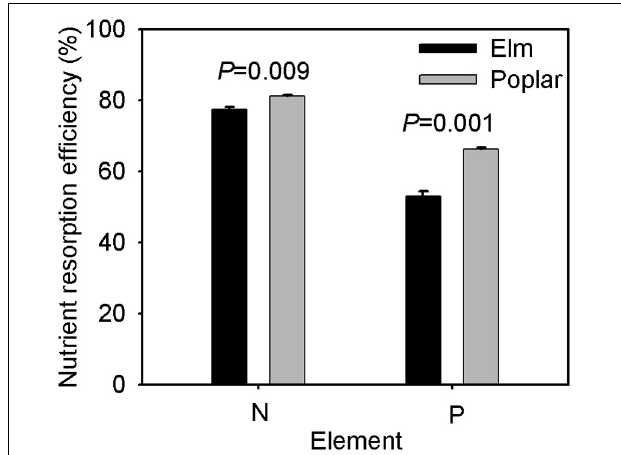
FIGURE 4 | N and P resorption efficiencies of Siberian elm and Silver poplar ( n =